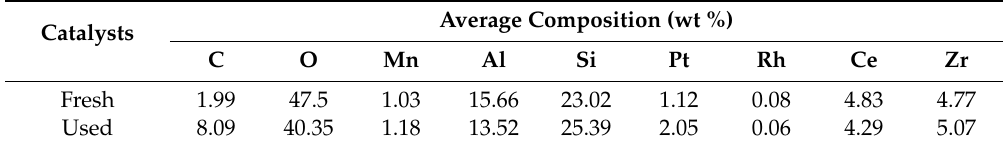
Figure 10. XRD patterns of Pt/Rh TWC catalysts for 2 θ between 10° and 90° in the fresh state and after the used state. The surface analysis of the catalysts (fresh and used catalysts) is performed by X-ray photoelectron spectroscopy (XPS). The XPS results in the expected detection of Pt, Rh, O, Ce, C, and Zr on the surfaces of the catalysts studied. Table 3 summarizes the results derived from the quantitative analysis of the XPS data. The quantitative surface analysis of the catalysts is based on the